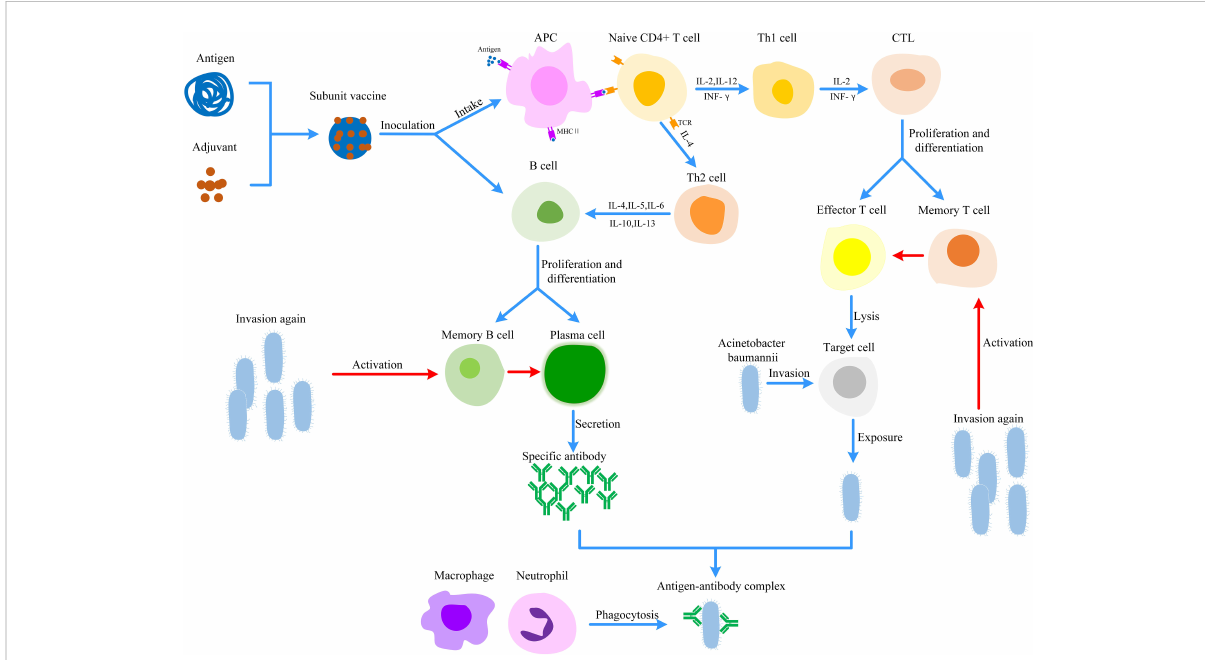
FIGURE 3 Protective mechanism of Acinetobacter baumannii subunit vaccine. Antigens can be taken up and digested into fragments by APC. These antigen fragments are recognized by TCR on CD4+ T cells, which activates cellular immunity to lysis target cells. In parallel, subunit vaccines or cytokines could activate B cells to induce humoral immunity. Once A. baumannii invades the body again, memory T cells and B cells could induce rapid and effective immune responses. (APC, Antigen-presenting cell; CTL, Cytotoxic T lymphocyte; MHC, Major histocompatibility complex; TCR, T cell